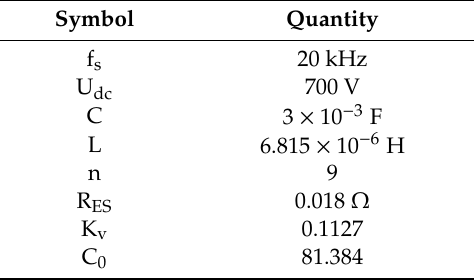
Figure 6. Simulation model of the DAB-SC system based on Matlab / Simulink: ( a ) The overall model; ( b ) model of the DAB converter. Table 1. Simulation